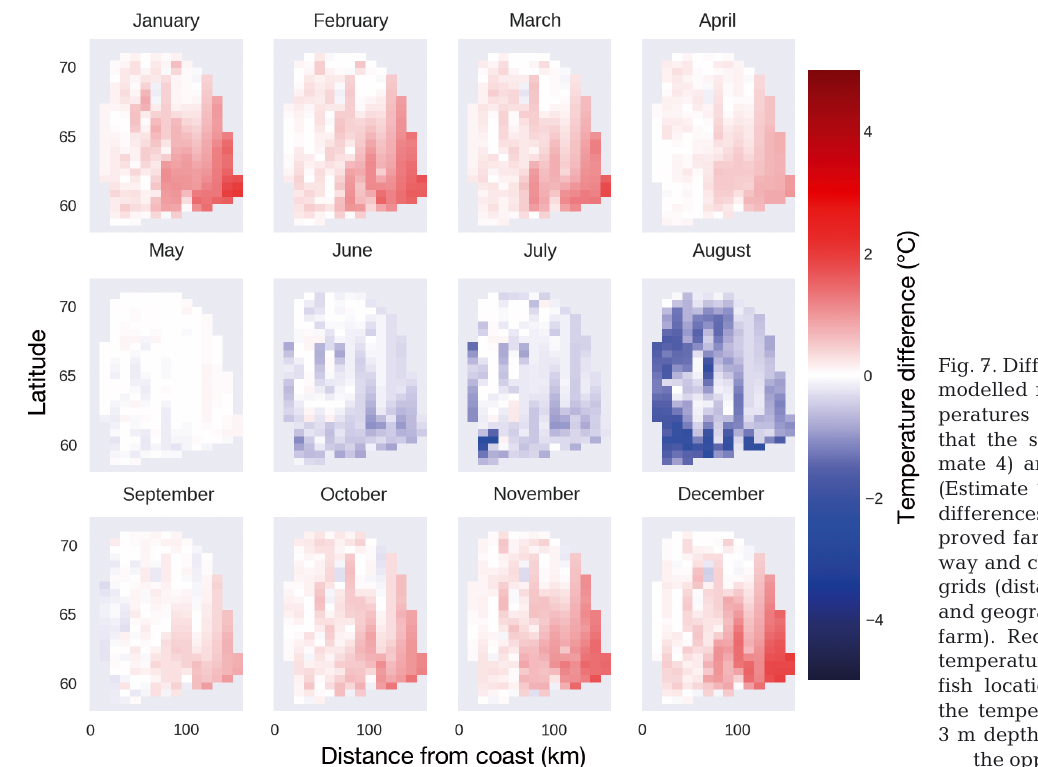
Fig. 7. Difference between the modelled monthly mean tem- peratures where we assume that the salmon reside (Esti- mate 4) and from 3 m depth (Estimate 1). The